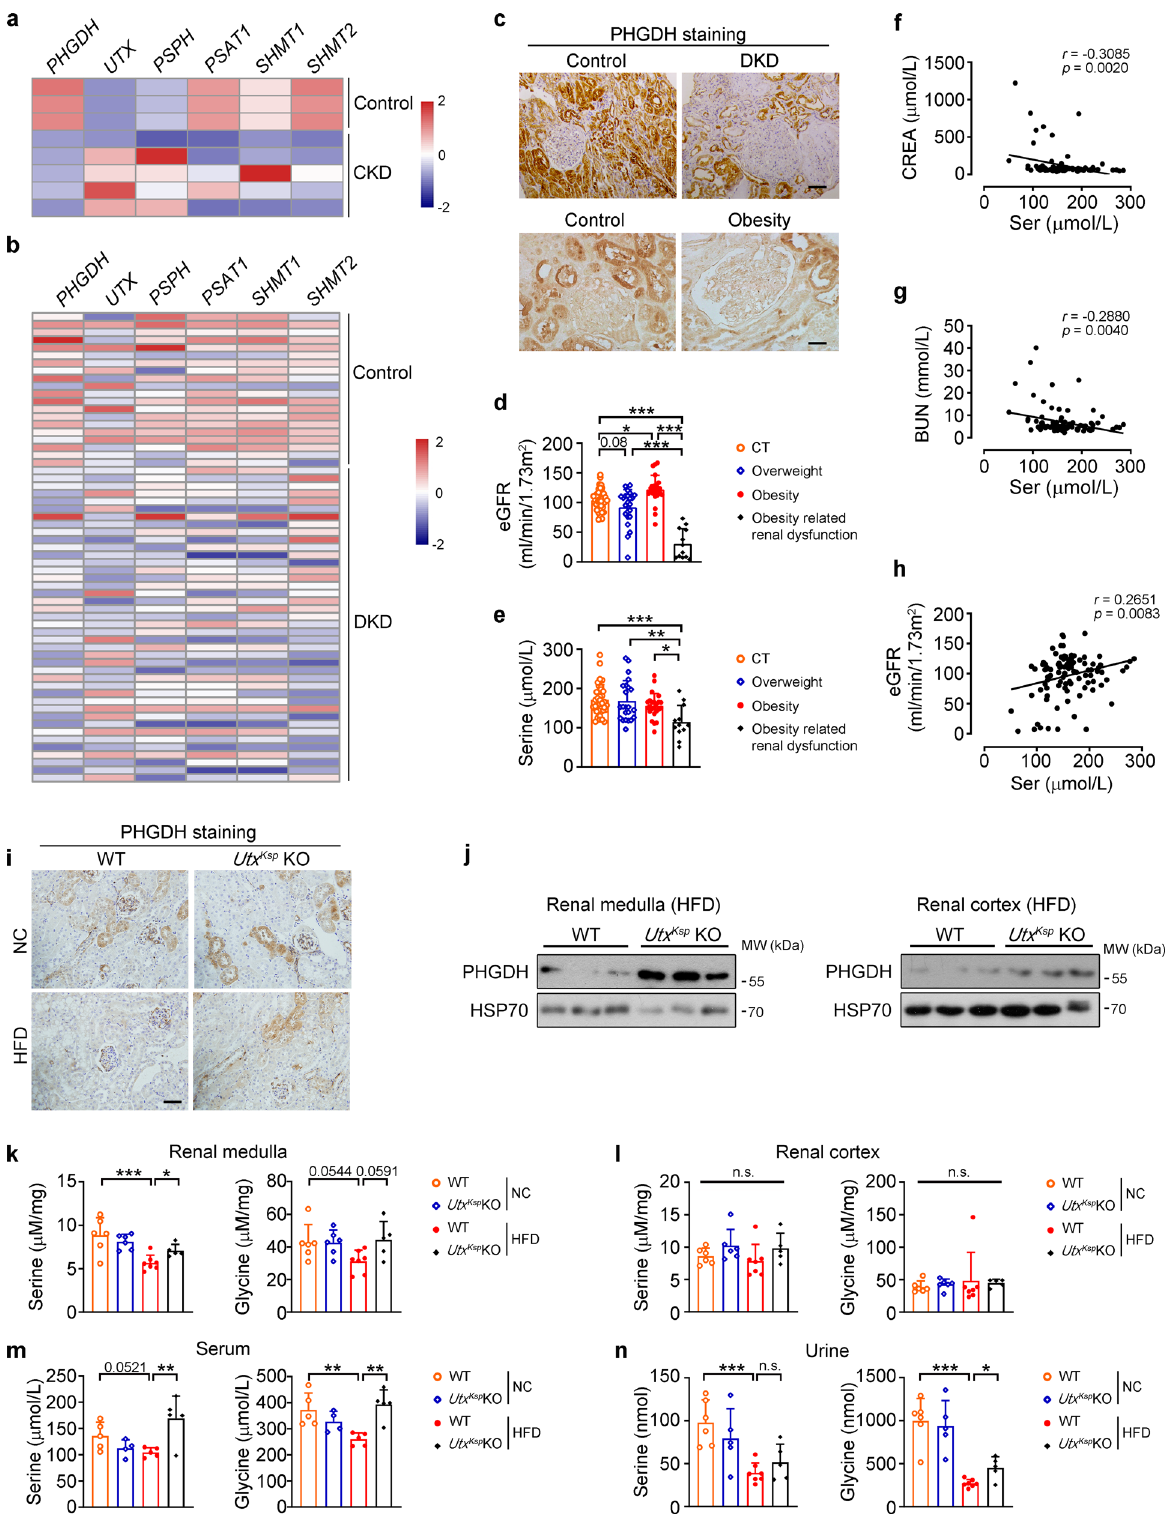
K384) as potential ubiquitination site(s). Six respective lysine to arginine PHGDH mutants were constructed. Compared to the wildtype, K310R and K330R mutations dramatically abolished UTX-promoted PHGDH ubiquitination (Fig. 8k), and mark- edly restored PHGDH level (Fig. 8l). These results indicate K310 and K330, which respectively reside on the surface of substrate binding domain and regulatory domain (Fig. 8m), are